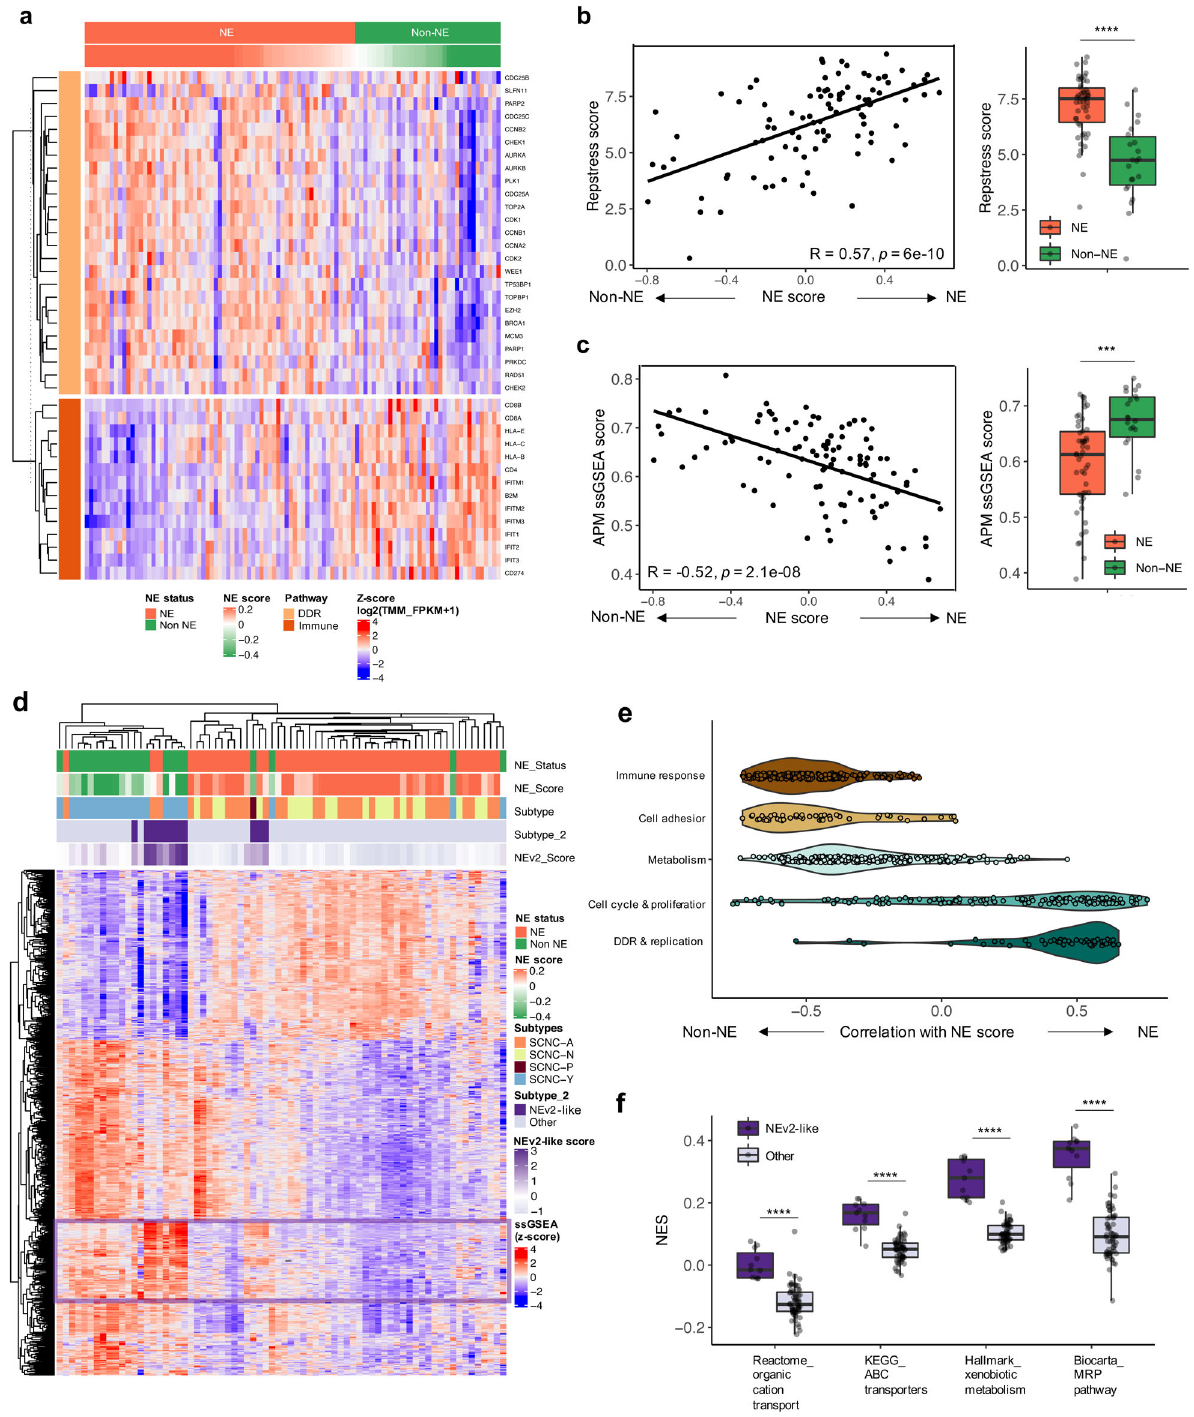
number of systemic therapies (HR, 2.87; 95% CI, 1.1 – 7.5; P = 0.031). Importantly, patients with NEv2-like tumors had signi fi cantly poorer OS compared with the rest of the cohort (9.8 vs. subtypes, the NEv2-like subtype was more likely to have a higher